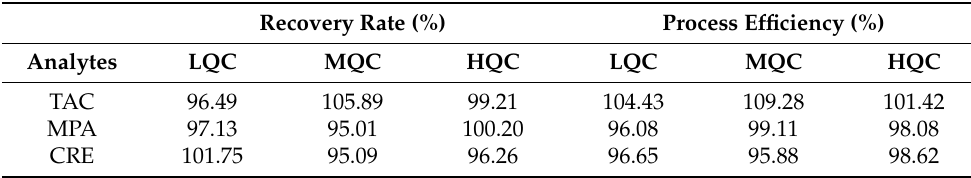
Table 3. Extraction recovery and process